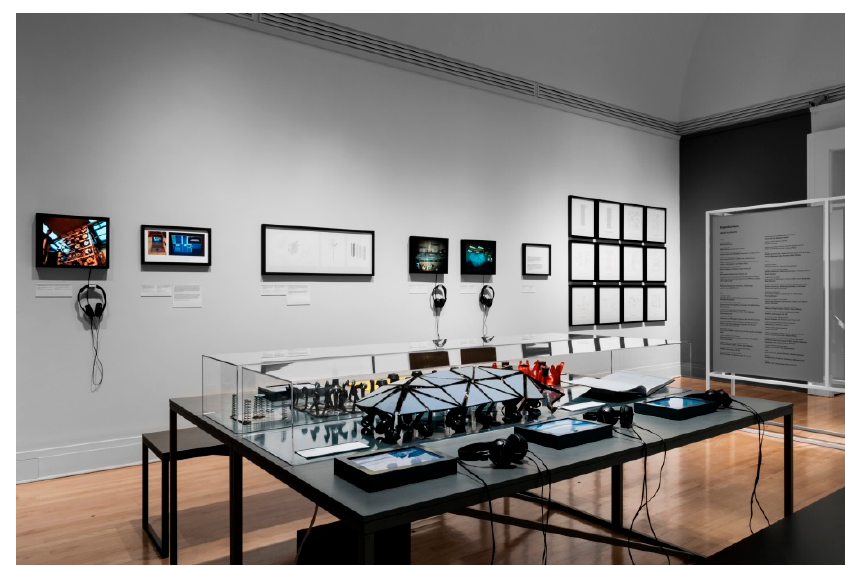
Figure 4. Archaeology of the Digital: Media and Machines, installation view of pieces related to Mark Goulthorpe’s Hyposurface, Canadian Centre for Architecture, 2014. Photograph: © CCA.